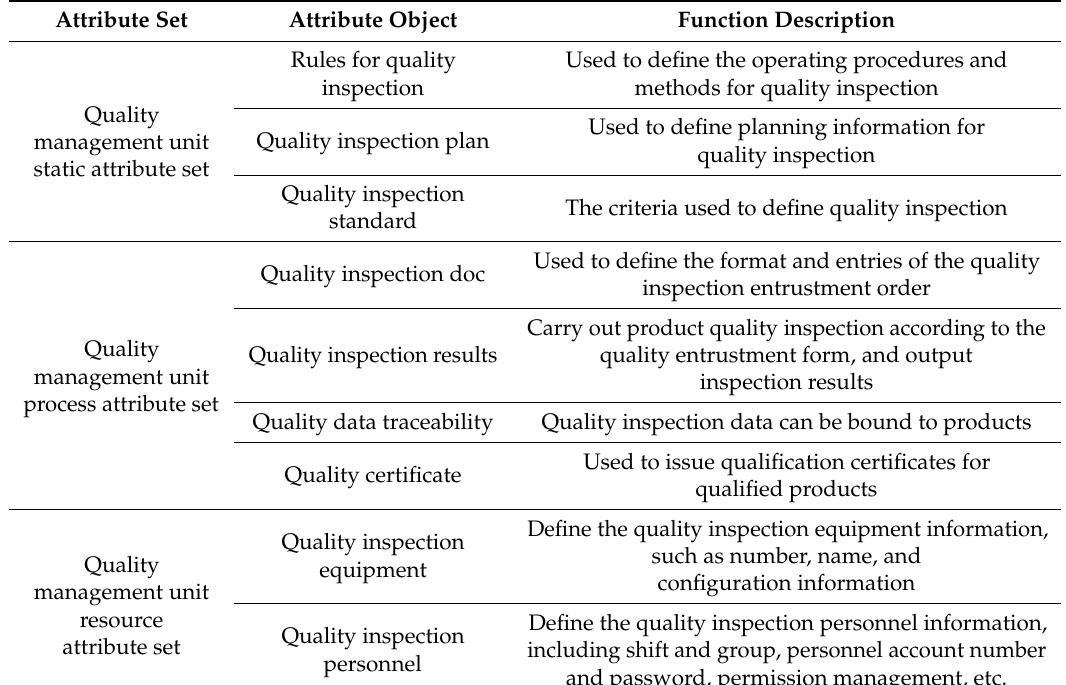
Table 5. Attribute objects and function descriptions contained by quality management unit